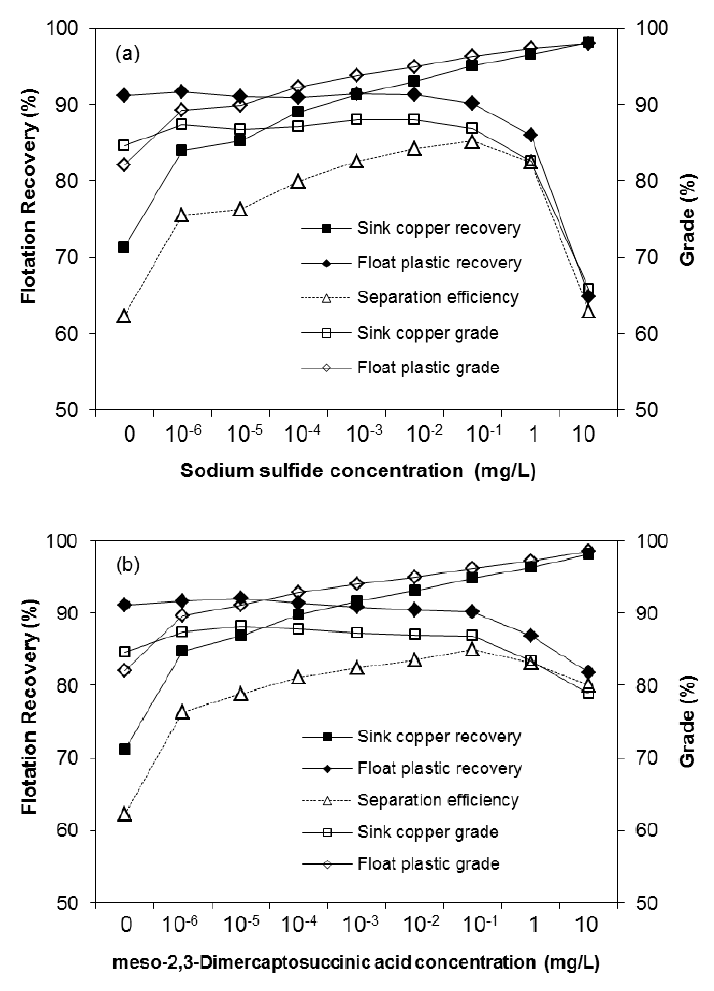
Figure 3. Recovery and grade of plastic in the floated, recovery and grade of copper in the sink, and separation efficiency versus sodium sulfide ( a ) and meso-2,3-Dimercaptosuccinic acid ( b ) concentration.